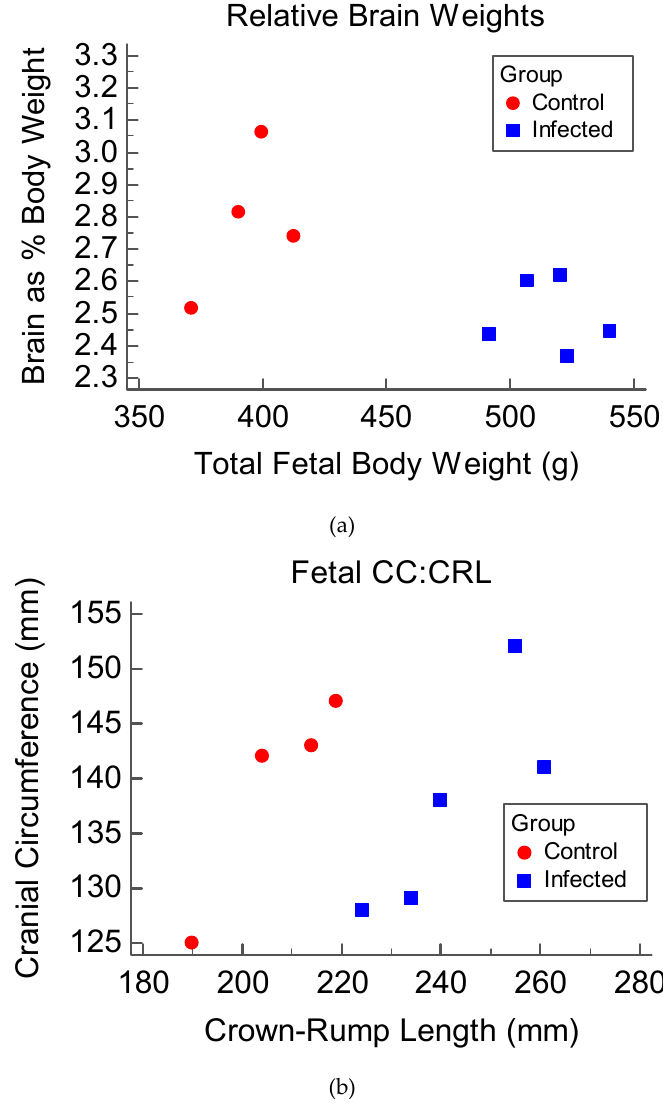
Figure 2. Morphometric ratios examining the brain size of fetuses at the time of necropsy (45 to 47 DPI, corresponding with a gestational age of 81 to 89 days). Morphometric ratios were calculated from fetal measurements and compared between infected ( blue ) and control groups ( red ): ( a ) The relative brain weights (brain as a percentage of body weight plotted against total body weight); ( b ) Cranial circumference plotted against crown-rump length, used to evaluate proportional head size.